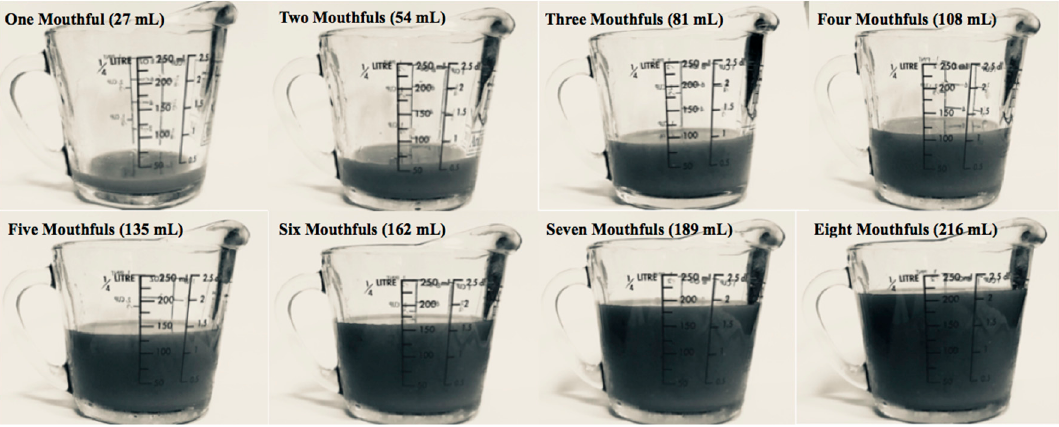
Figure 1. The figure illustrates one to eight mouthfuls of liquid in a one-cup/250 mL measuring glass, assuming one mouthful is equal to 27 mL of liquid